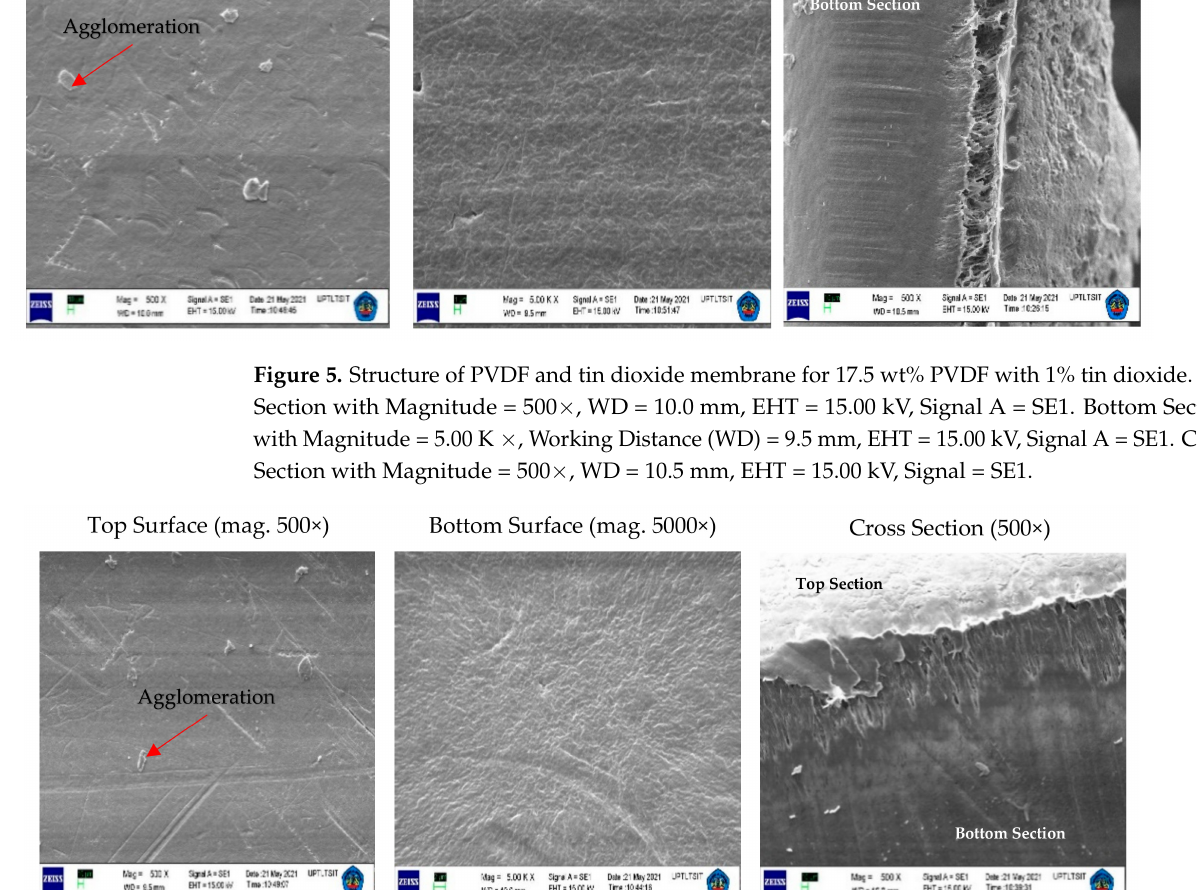
Figure 6. Structure of PVDF and tin dioxide membrane for 20 wt% PVDF with 1% tin dioxide. Top Section with Magnitude = 500 × , Working Distance (WD) = 10.0 mm, EHT 15.00 kV Signal A = SE1, Bottom Section with Magnitude = 5.00 K × , WD = 9.5 mm, EHT = 15.00 kV, Signal A = SE1. Cross Section with Magnitude 500 × , WD = 10.5 mm, EHT = 15.00 kV, Signal